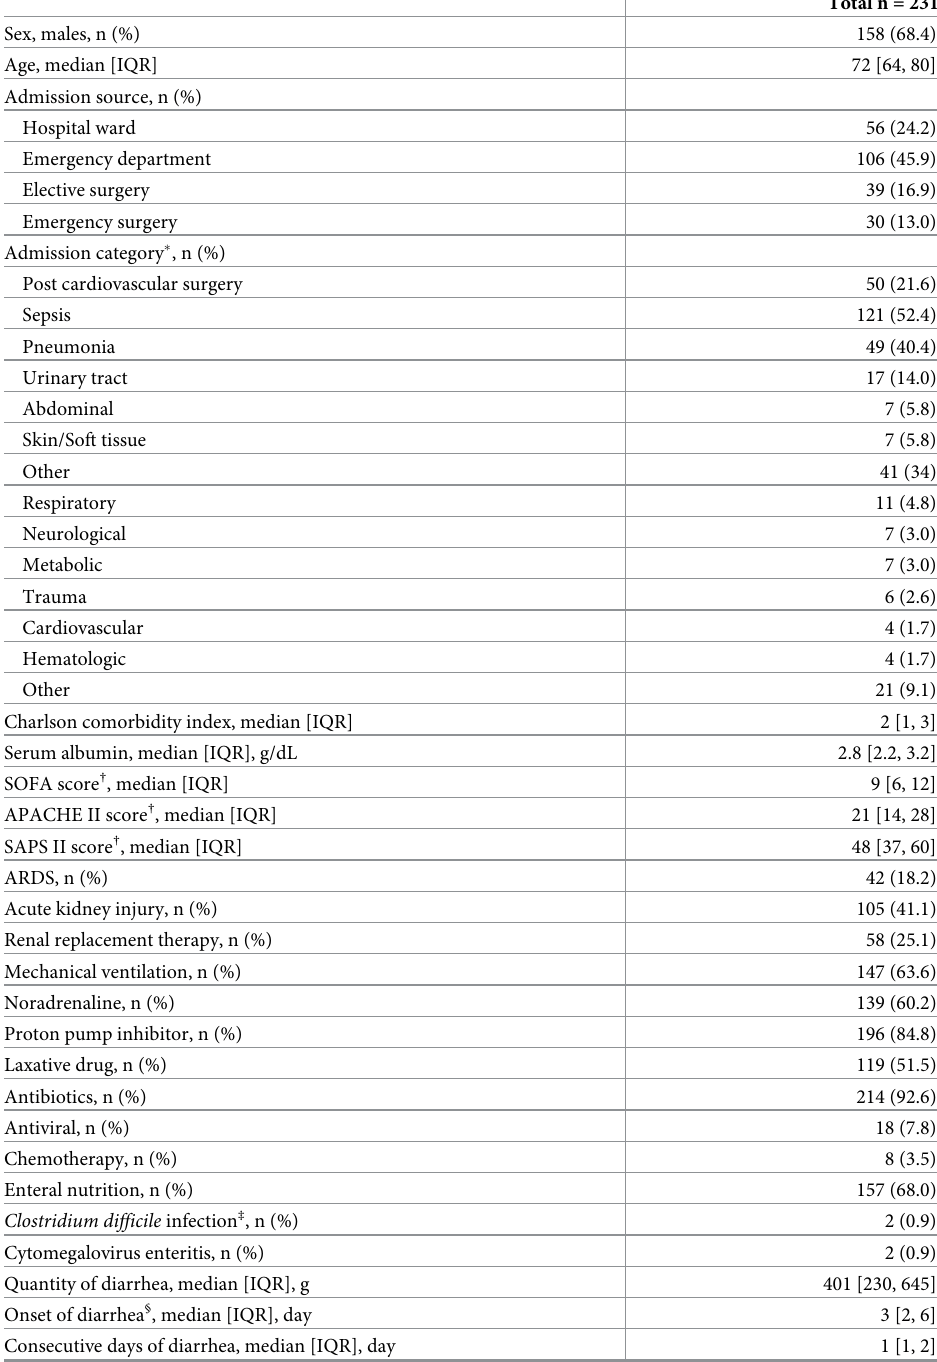
Table 1. Baseline characteristics of the study